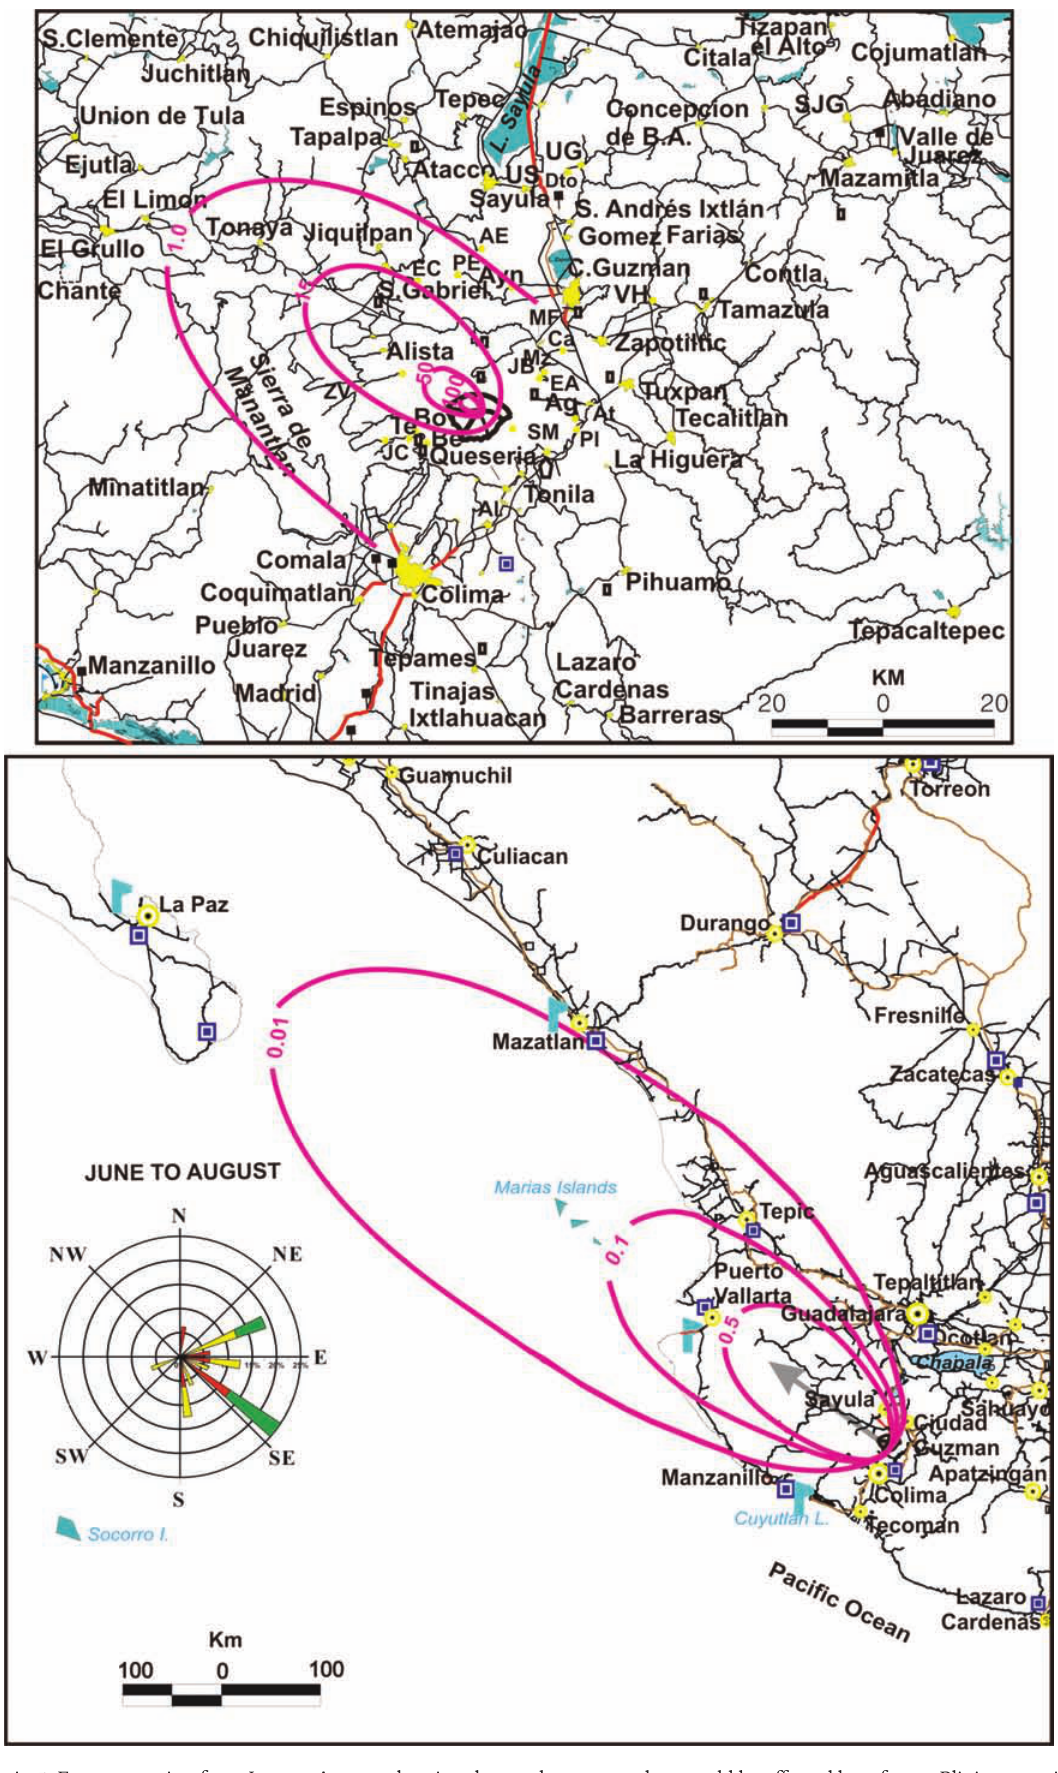
Figure 8. Scenario 5. For an eruption from June to August, showing the northwest area that would be affected by a future Plinian eruption. For details, see legend to Figure